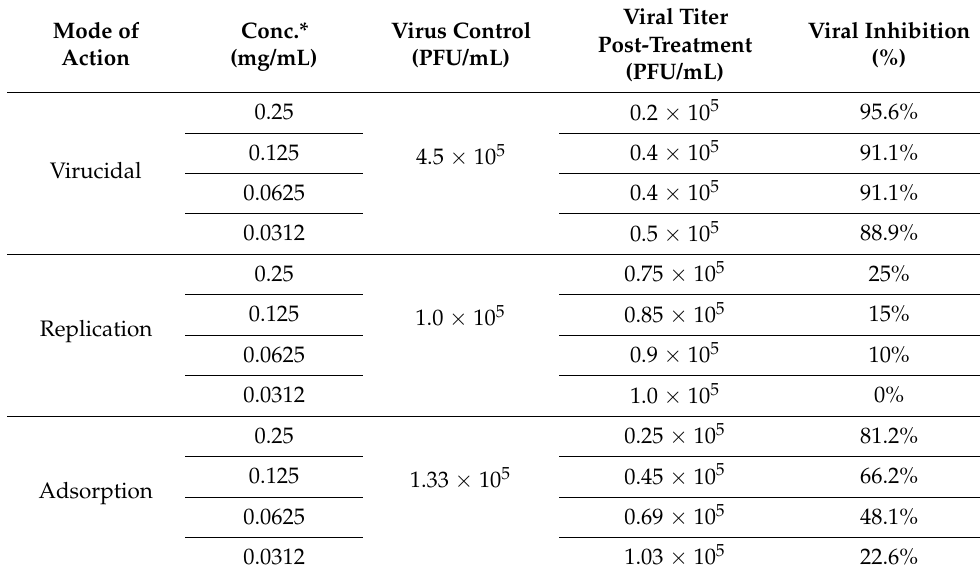
Table 2. Mechanism of the antiviral activity of APEE against SARS-CoV-2.